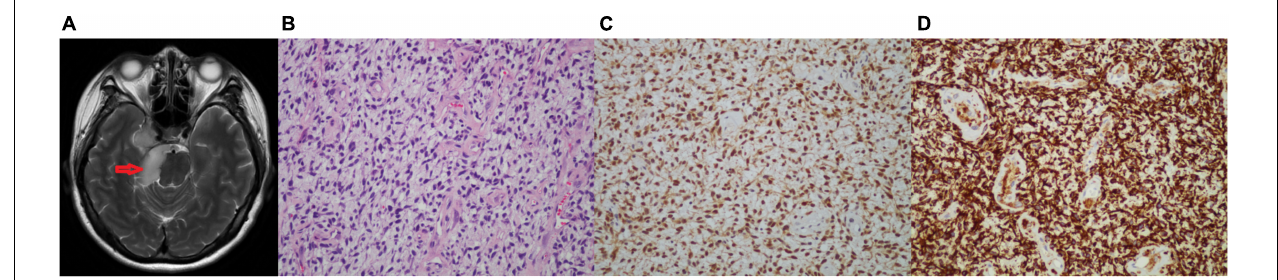
FIGURE 2 | (A–D) Images of the brain tumor. (A) The head MRI (axial showed images) showing a 4.6 × 2.2 cm neoplastic lesion in the trigeminal area. (B) H&E-stained (200 × ): the tumor tissue is composed of homogenous spindle cells, arranged in bundles, swirls, and sheets, mitotic activity, and rich blood vessels.